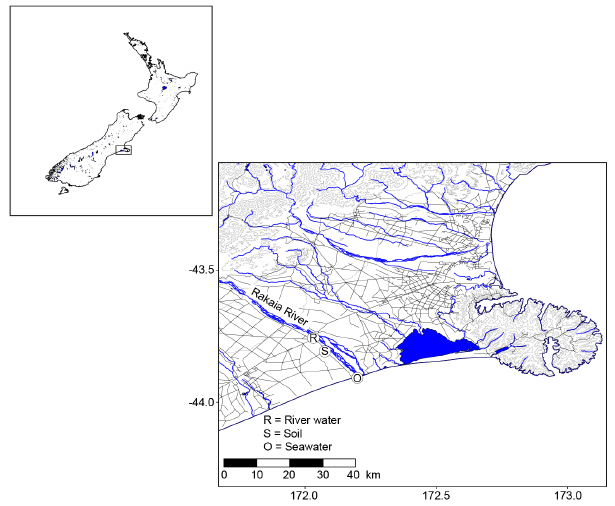
Figure 2. Overview map of the Rakaia River, South Island, New Zealand, indicating the sampling